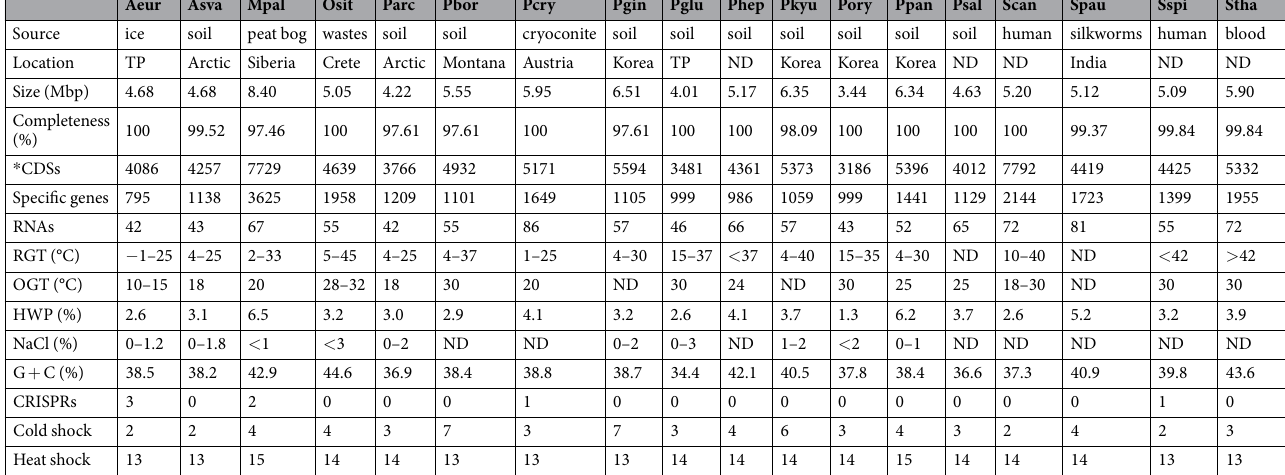
Table 1. Genomic and phenotypic characteristics of strains in the family Sphingobacteriaceae with a sequenced genome. * Abbreviations: CDSs, coding sequences; RGT, range of growth temperature; OGT, optimal growth temperature; HWP, homology within proteomes; TP, Tibetan Plateau; ND, no data. Abbreviations for Sphingobacteriaceae strains are defined in Fig. 2